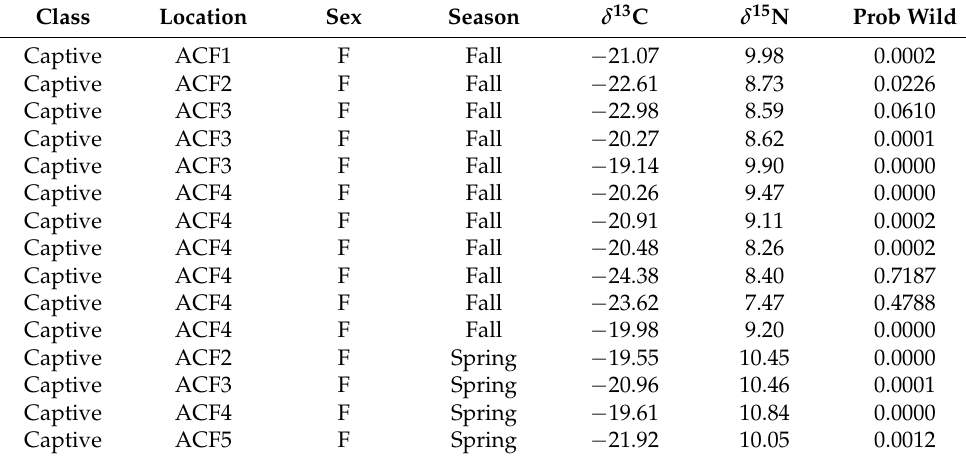
Table 1. Carbon ( δ 13 C) and nitrogen ( δ 15 N) stable isotope values for wild wood turtles captured in Maine and captive wood turtles sampled at various animal care facilities throughout the eastern United States. Prob Wild is the predicted probability that each turtle in the study is wild based on the stable isotopic composition of their claw tips and their